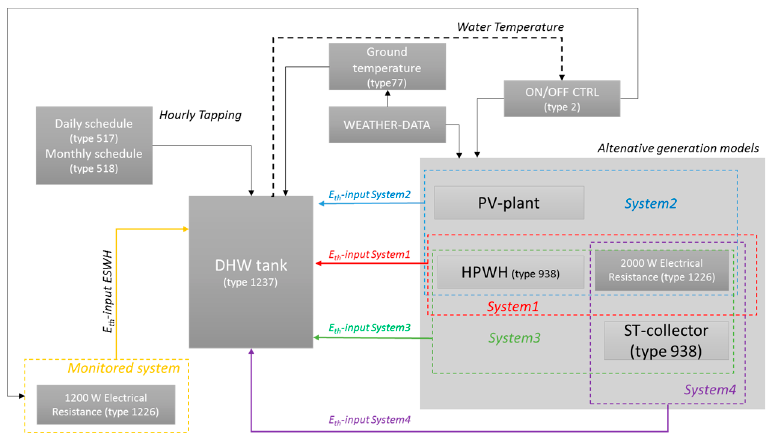
Figure 4. Trnsys model scheme.